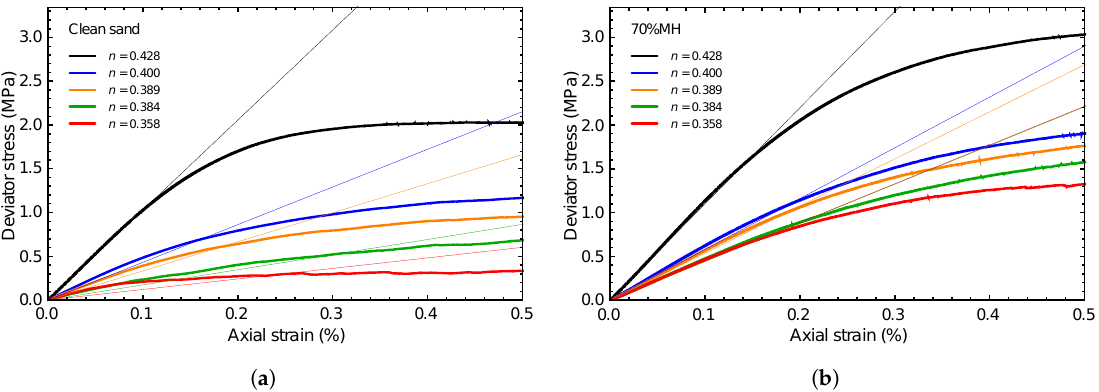
Figure 7. Stress-strain curves: ( a ) clean sands; ( b ) “70%MH” samples. Colors represent different porosities (thin lines = a linear relation based on E 50